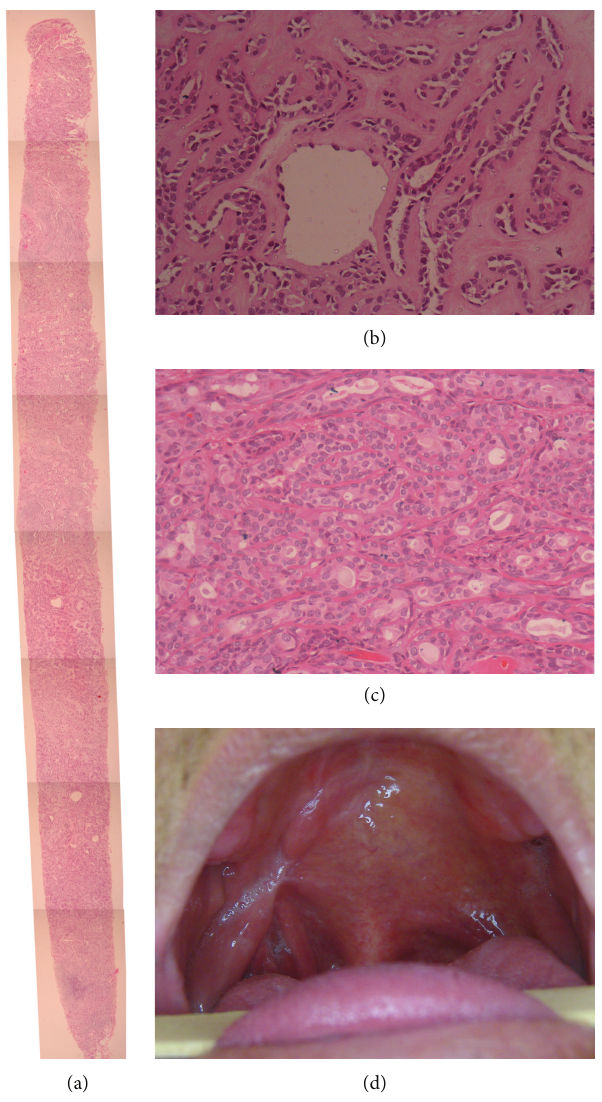
Figure 4: Histopathological aspects of entire fragment obtained after CNB (H&E × 40) (a) Strands and sheets of epithelial cells with ductal structures. Deposition of homogeneous, eosinophilic, hyaline material between tumor cells and dispersed in extracellular matrix (H&E × 100) (b) Histopathological aspects of surgical specimen confirming diagnosis of pleomorphic adenoma (H&E × 100) (c). Intraoral aspect at 12- month follow-up, with no signs of recurrence